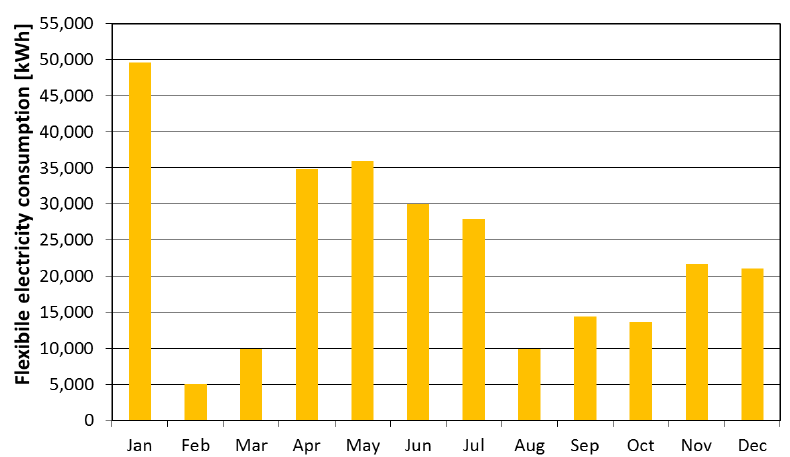
Figure 13. Monthly DES flexible consumption in the TO-BE scenario 1.